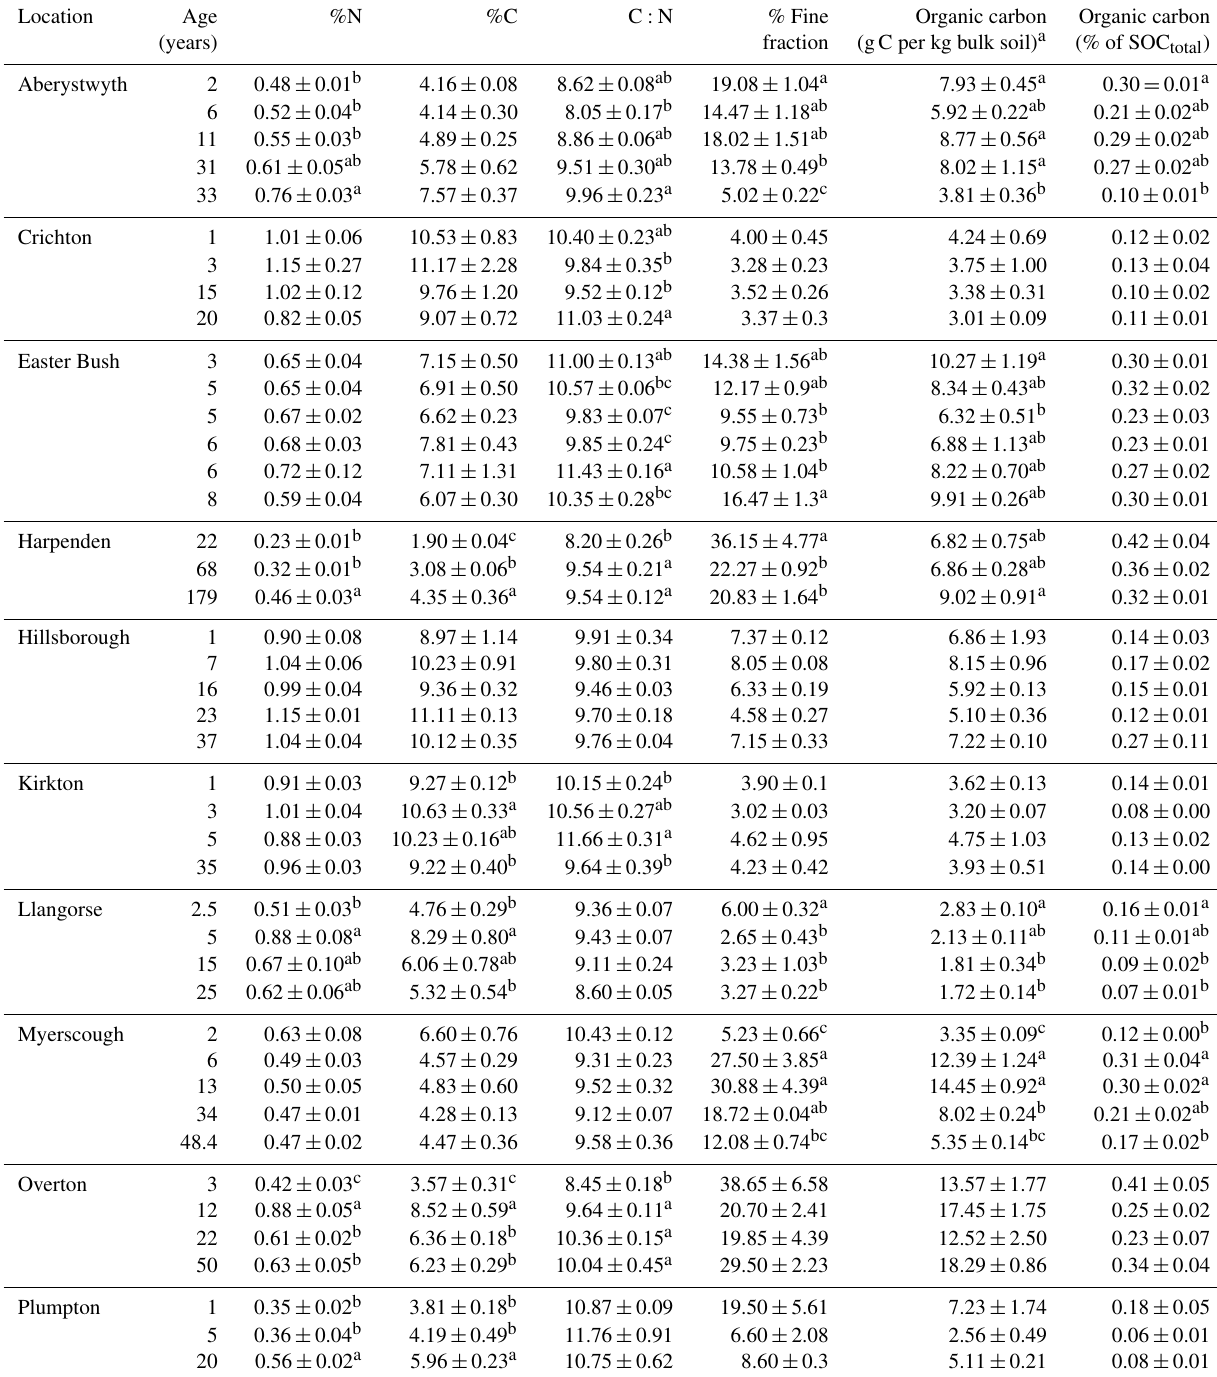
Table A2. Fine-fraction ( < 20µm) soil properties for each UK site. Values are means of three replicates in each field ± 1 standard error of the mean. Lettering indicates values that are significantly different, within a site ( p < 0 . 05).